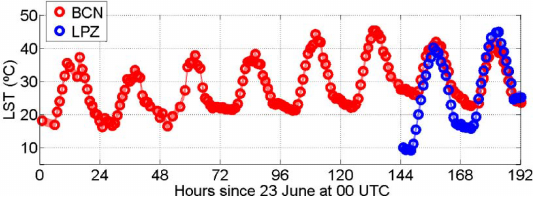
Figure 6. Hourly LST in BCN (red) and LPZ (blue). The associated uncertainty is added as a shaded area, although it is so small that it is almost